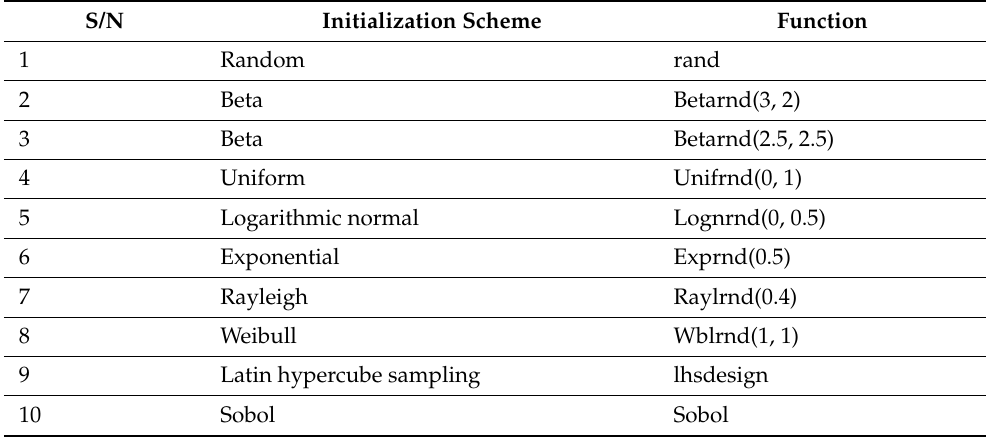
Table 10. Initialisation schemes.